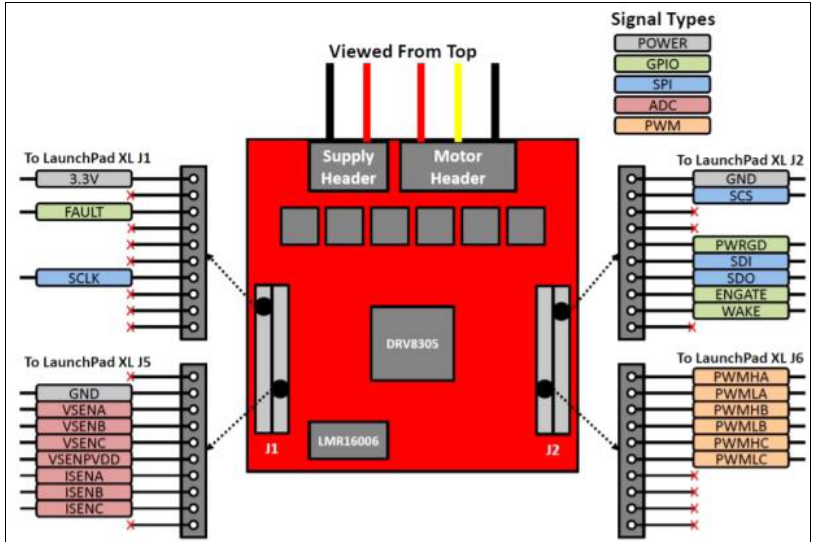
Figure 11. BOOSTXL-DRV8305EVM pinout